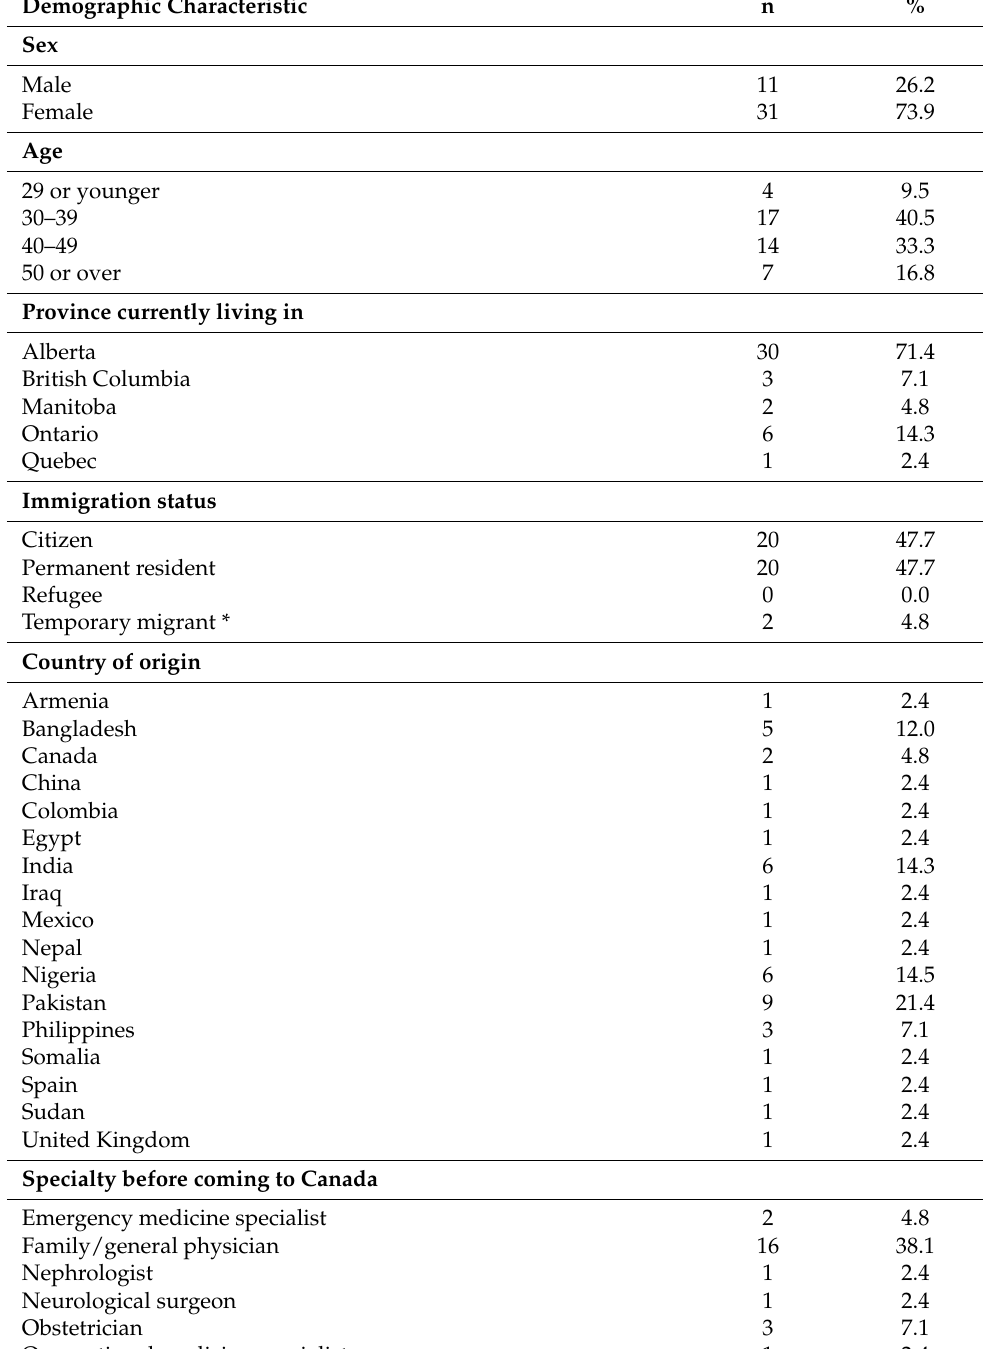
Table 1. Characteristics of study respondents (N =